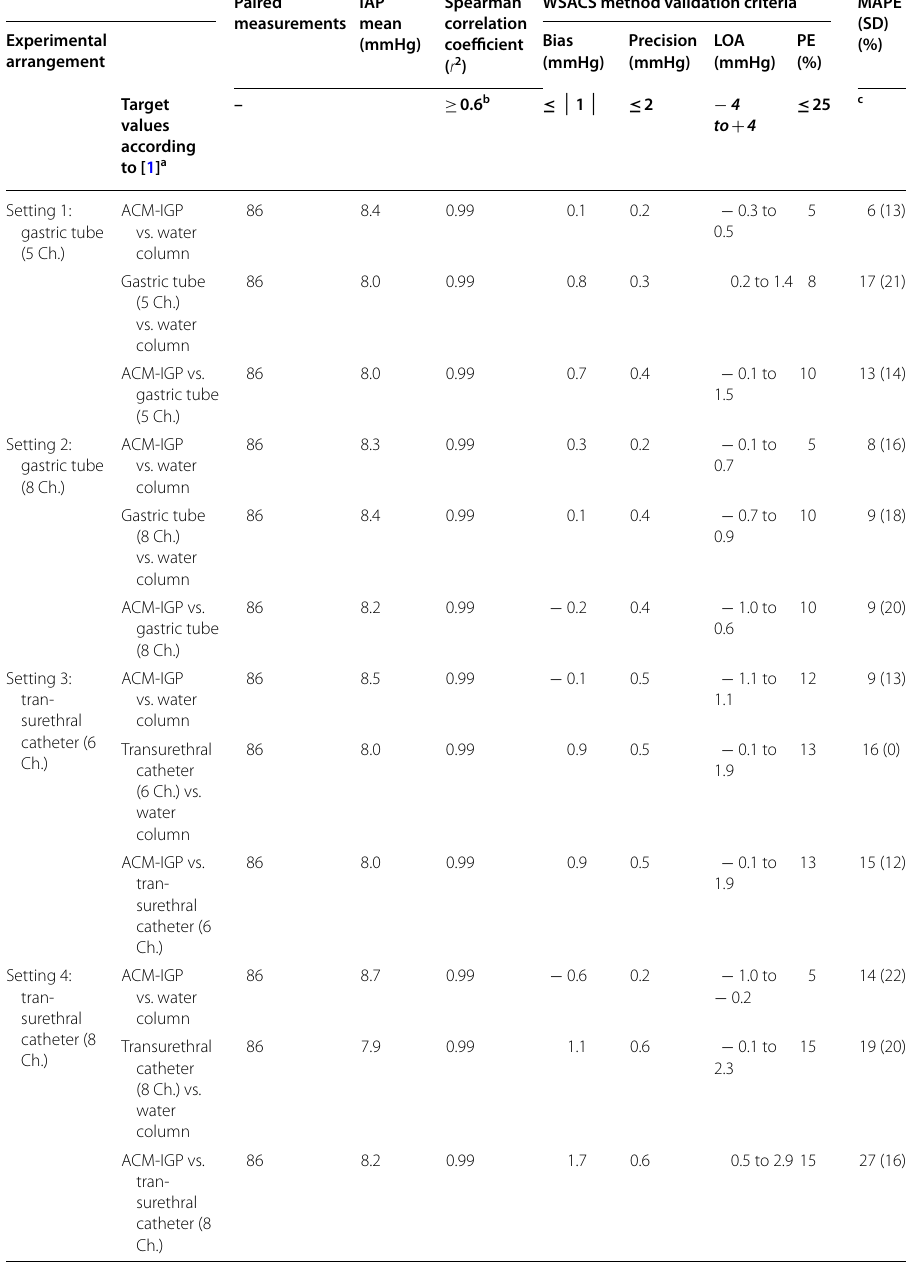
Table 3 Results of the in vitro examination of measurement agreement of IVP and ACM-IGP technique compared to a water column in a container model